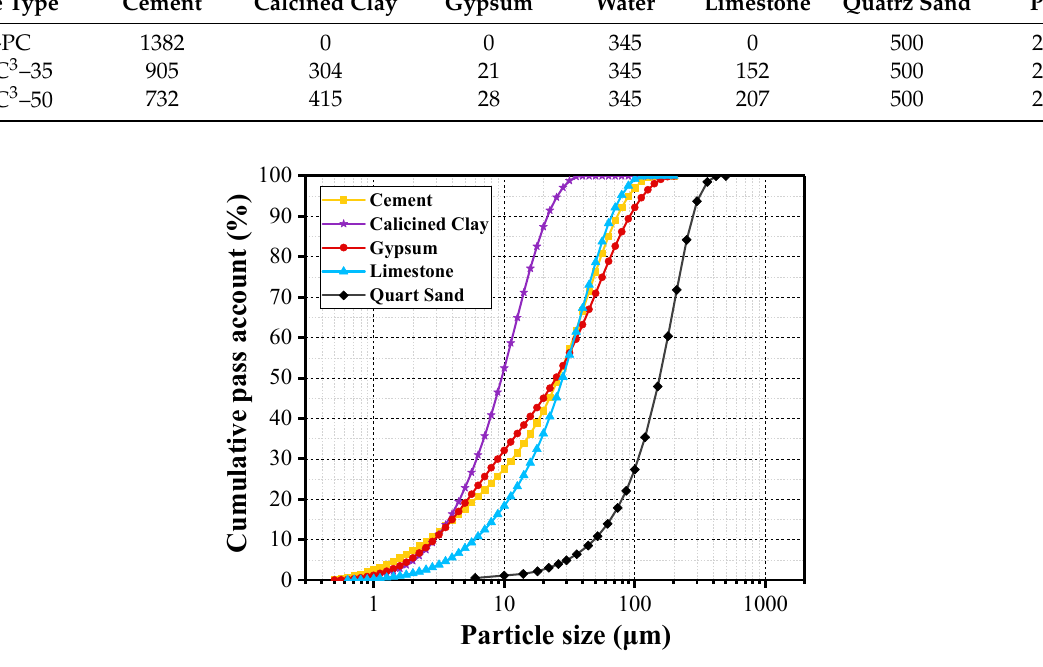
Figure 1. Grading curves of the ingredients. Table 1. Mixture proportion of ECC (kg/m 3 ).